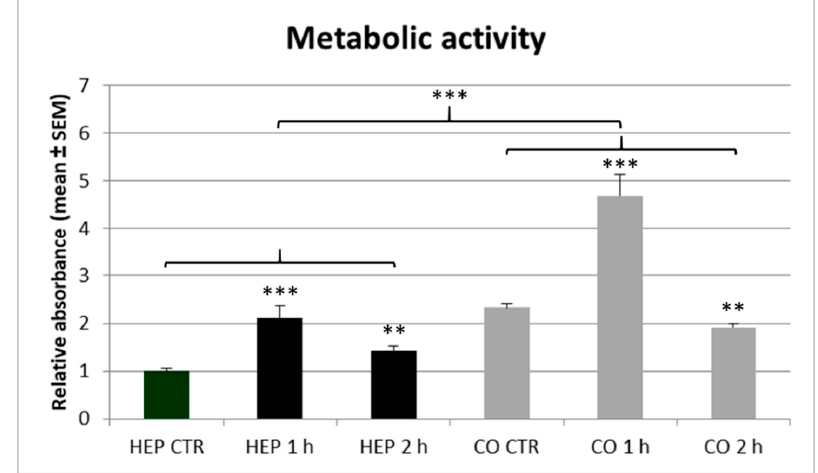
Figure 5. The metabolic activity of hepatocyte mono-cultures (“HEP”) and hepatocyte— nonparenchymal cell co-cultures (“CO”) as indicated by the CCK-8 assay. The “CTR” refers to control cells with no heat exposure, while “1 h” and “2 h” indicate incubation of cell cultures at 43 °C for 1 or 2 h, respectively. Results are expressed as mean ± standard error of the mean (SEM), n = 6/group. Asterisks over bars of “1 h” and “2 h” refer to significant differences compared to “CTR” cells within the same cell culture model. Significant differences between cell culture models are indicated with asterisks on the clamps. ** p < 0.01, *** p < 0.001.